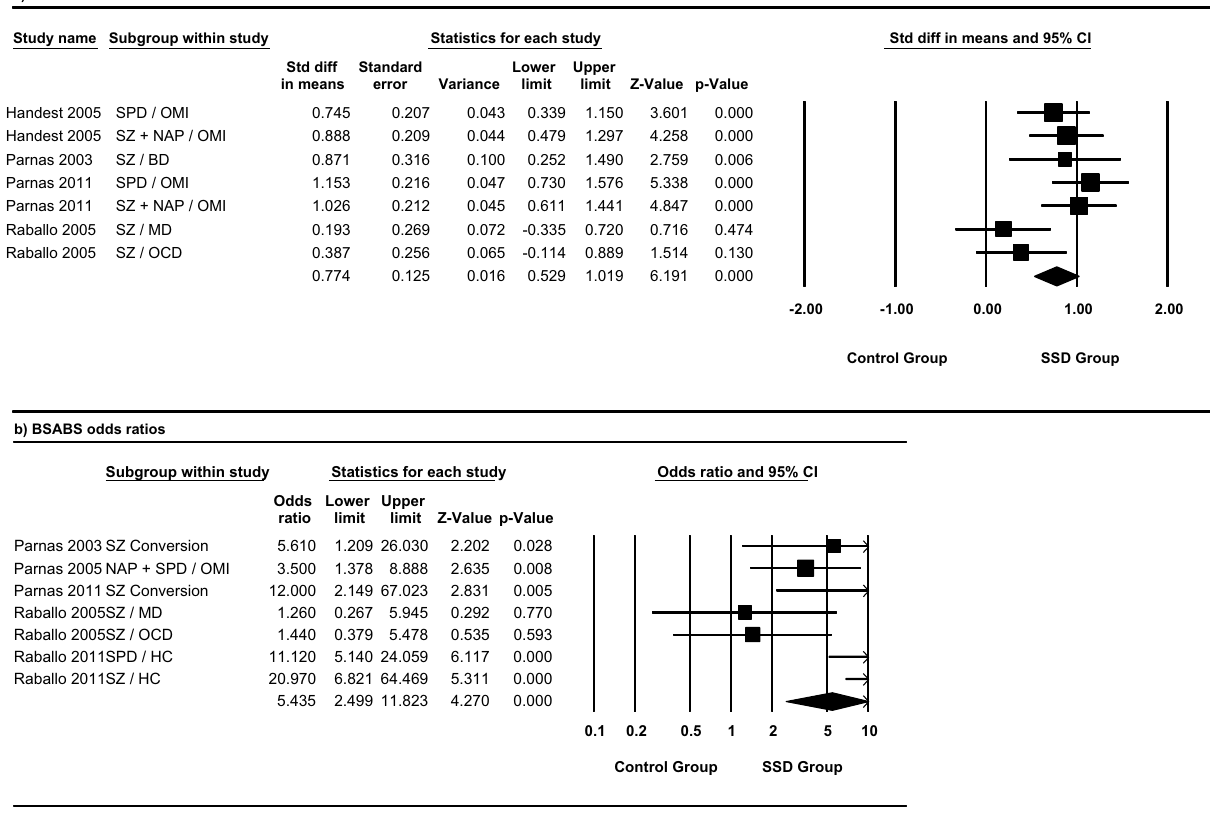
Figure 2. Meta-analysis of the aggregation and likelihood of developing self-disorders in schizophrenia spectrum and control groups, as measured with the Bonn scale for the assessment of basic symptoms (BSABS). Studies are grouped by outcome measure. ( a ) Describes the standard difference in means for total self-disorder score in schizophrenia spectrum and control groups. ( b ) Describes the odds ratios of developing self-disorders in schizophrenia spectrum and control groups. Data shown as mean ± SEM of self-disorder scores for ( a ) and log odds ratio ± SE for ( b ). Both are representative of two independent samples; values are significant if p < 0.05. BD = bipolar disorder, HC = healthy control, MD = mood disorder, NAP = non-affective psychosis, OCD = obsessive compulsive disorder, OMI = other mental illness, SD = self-disorder, SPD = schizotypal personality disorder, SZ =